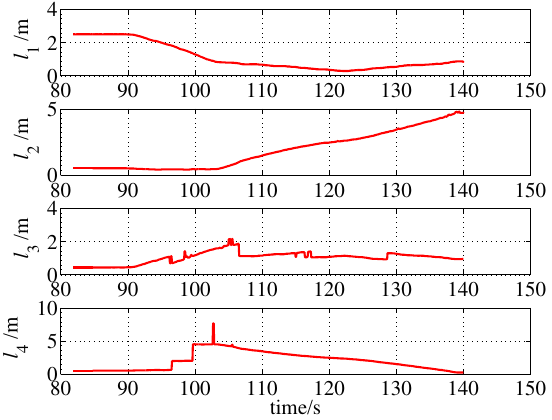
Figure 23. Sonar measurements (with an unmodeled